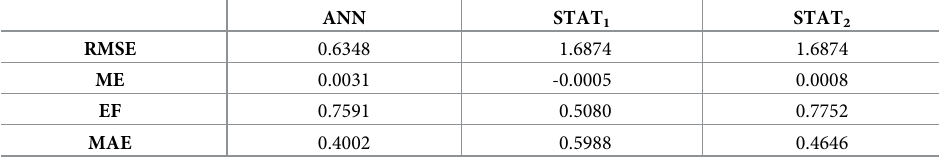
Table 7. Accuracy measurements of the artificial neural network model (ANN), the polynomial regression equa- tions (STAT 1 and STAT 2 ) for the estimation of the double bark thickness for oak.